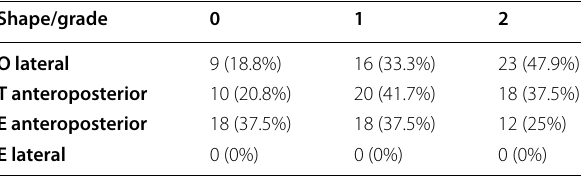
Table 3 VOTE graduation in oropharynx, tongue base, and